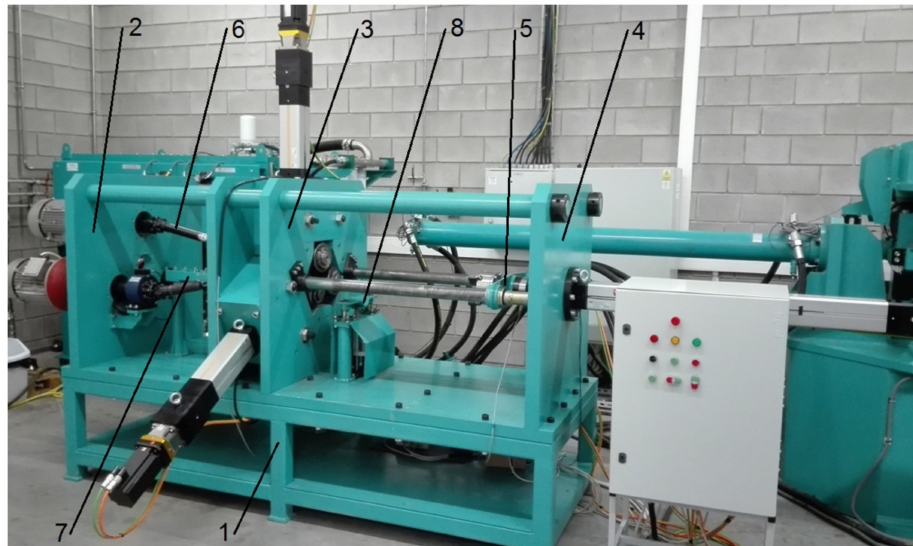
Figure 3. Rolling mill used in bimetallic rod rolling tests: 1—support frame; 2—drive unit; 3—rolling cage; 4—axial travel unit; 5—gripper and workpiece guide units; 6—torque transmission; 7—material feeding unit; 8—workpiece support unit.